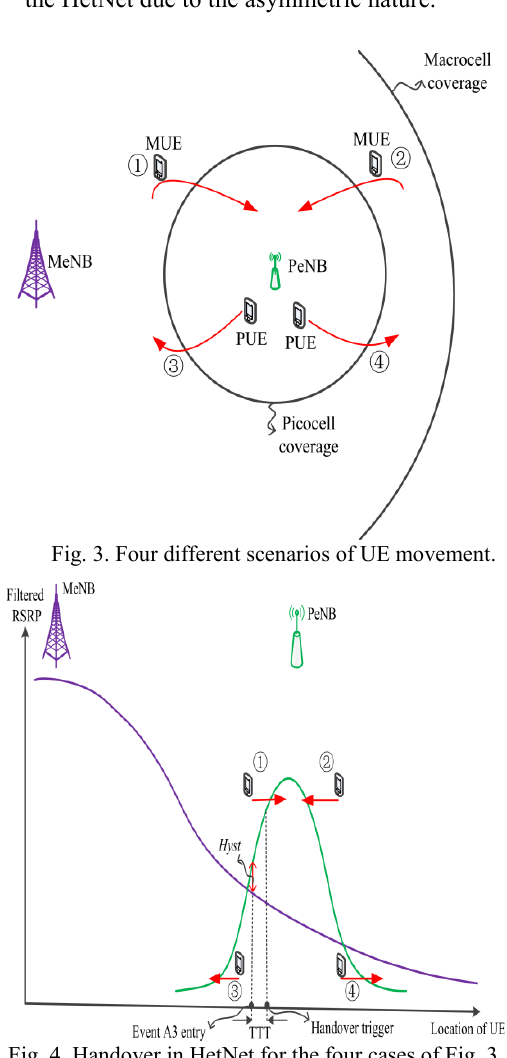
Fig. 4. Handover in HetNet for the four cases of Fig.